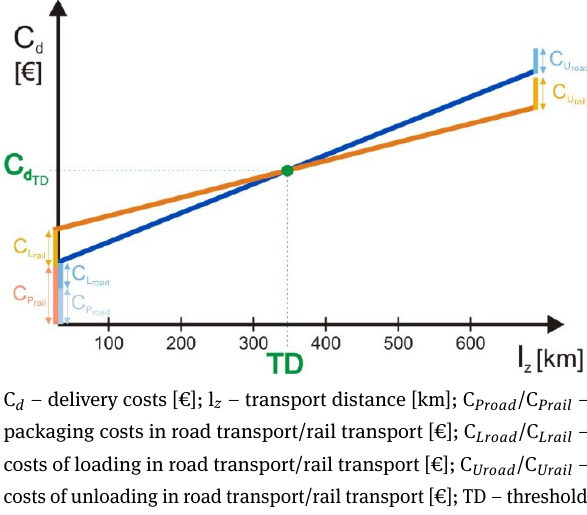
Figure 1: Graphical representation of the determination of the threshold distance based on the delivery costs from the consignor to the consignee [authors]